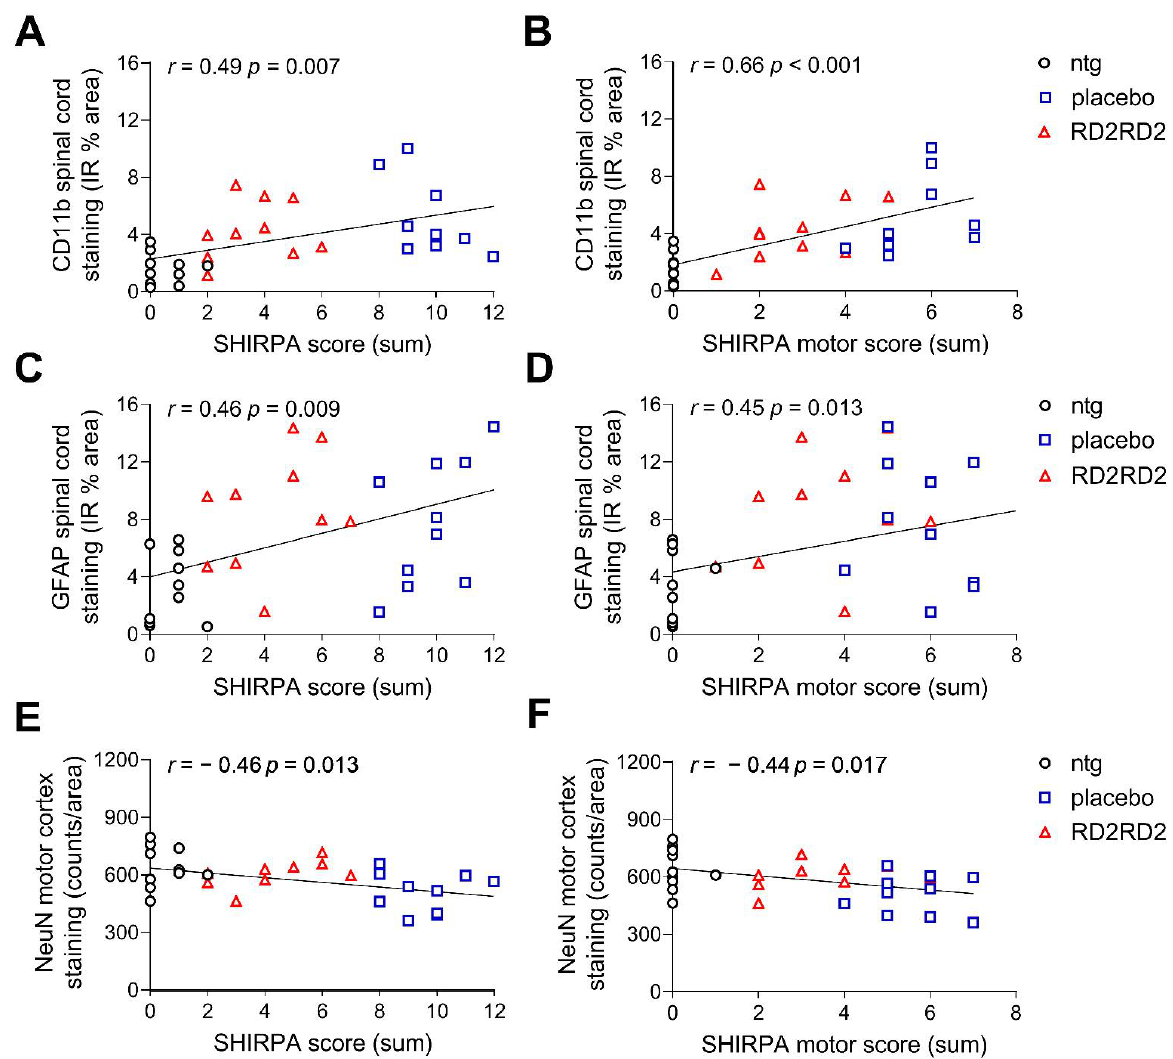
Figure 4. Correlation between histological quantifications and SHIRPA scores over all three groups. Significant correlation was observed between quantified microglia ( A , B ) and astrocytes ( C , D ) in the spinal cord and the SHIRPA scores of mice. Calculation of the correlation coefficient was performed between quantified mature neurons ( E , F ) in the motor cortex and the SHIRPA scores over all three groups. Data were analysed using Pearson correlation coefficient (r). IR: immunoreactiv- ity.